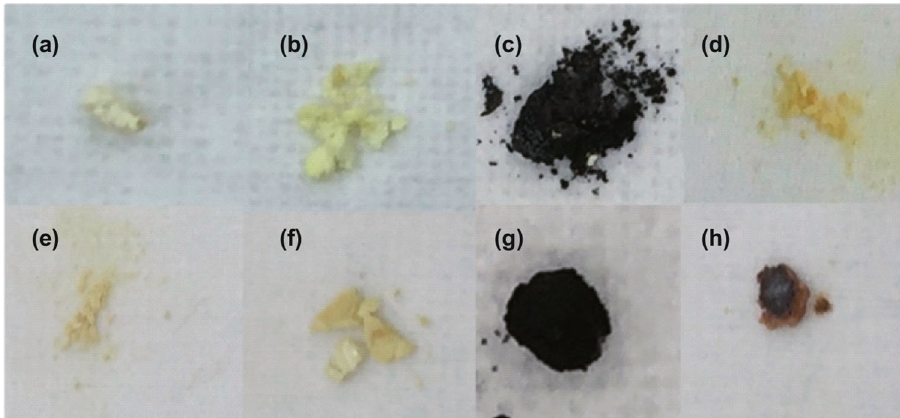
Fig. 10 As-prepared perovskite material powder treated by microwave irradiation for a 0 min, b 1 min, c 2 min at 800 W and the PbI 2 – CH